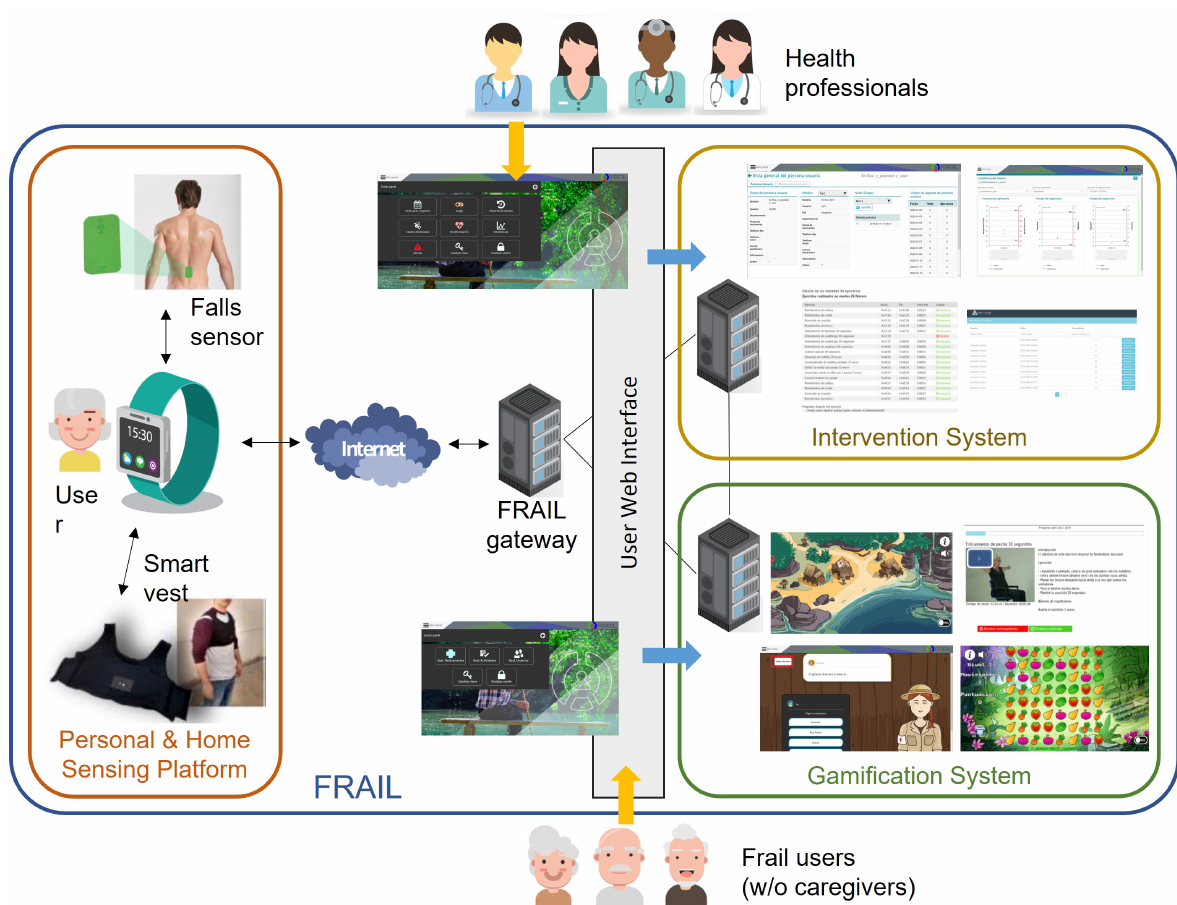
Figure 1. FRAIL architecture and main